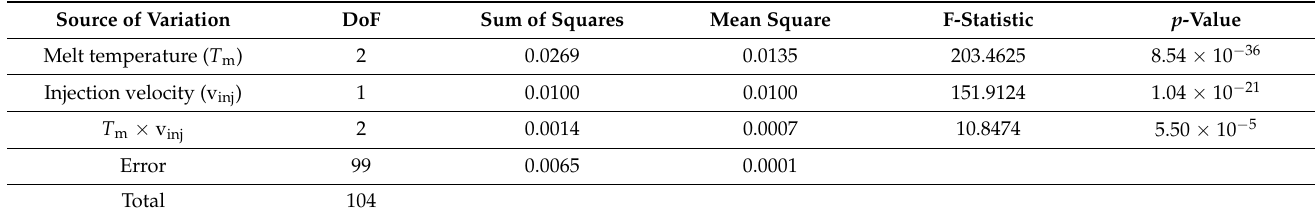
Table A1. Analysis of the main effects and interactions for the left side of the mold.